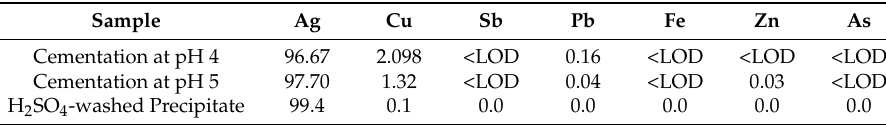
Table 6. Silver precipitate composition in wt.